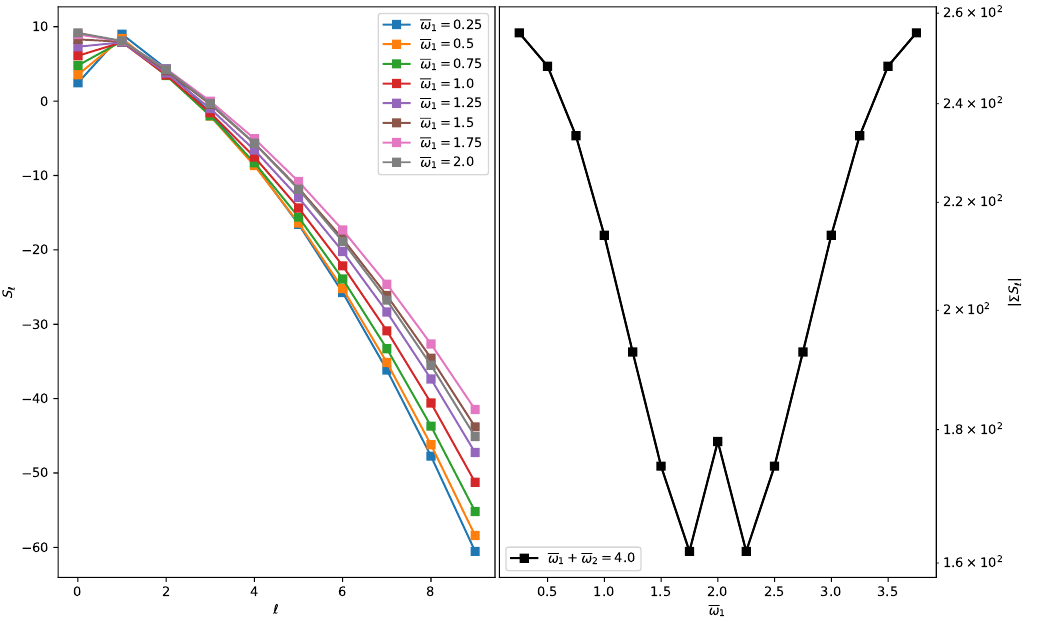
Figure 3. Left : source term values for a tachyonic scalar with m 2 = − 1 . 0 when the frequencies of non-normalizable modes sum to 4 . 0 . Right : the absolute value of the sum of the source terms for each choice of ω 1 , ω 2